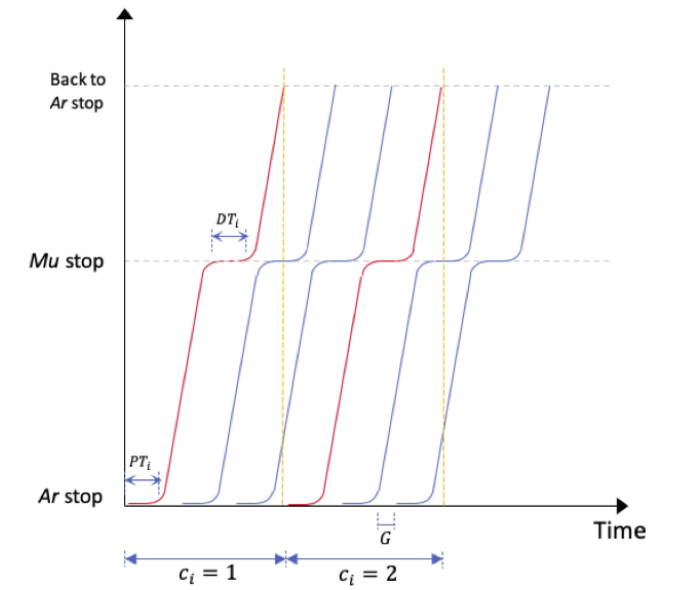
Figure 2. Time-space diagram of one office shuttle